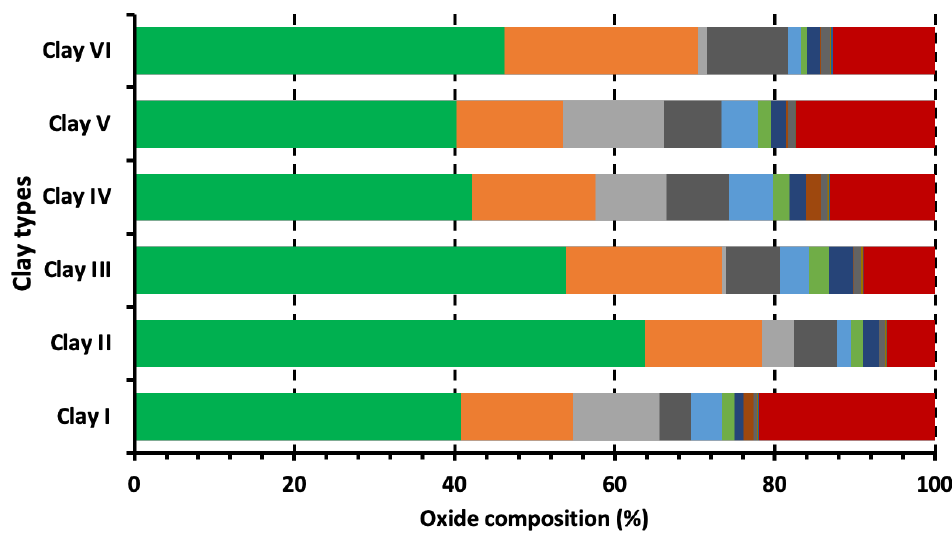
Figure 7. Chemical composition of clays.